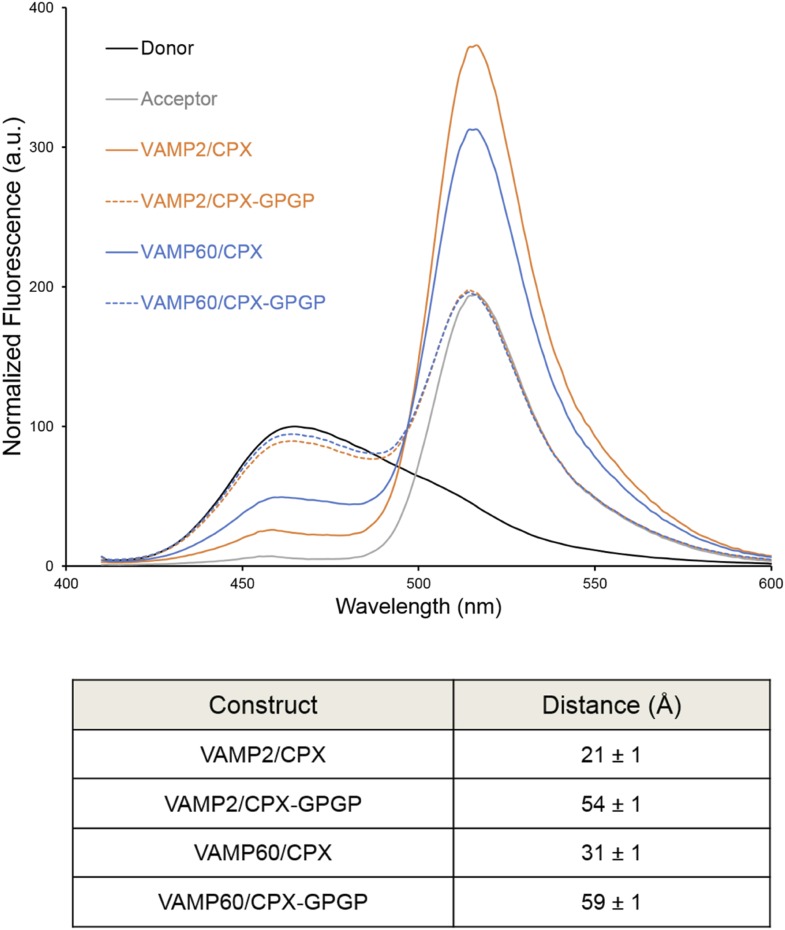
Bimane–Oregon green fluorescence resonance energy transfer (FRET) experiments probing the effect of flexibility on complexin (CPX) orientation in pre- and post-fusion CPX–SNARE complexes.The FRET labeling positions were residue 193 on SNAP25 (Bimane) and residue 38 on CPX (Oregon green). Fluorescence emission spectra of Bimane only (black), Oregon green only (grey), and Bimane–Oregon green labeled CPX–SNARE complexes containing VAMP2 (residues 25–96, orange), VAMP60 (residues 25–60, blue) confirms the angled (low FRET) configuration of CPX accessory helix (CPXacc) in the pre-fusion SNARE complex (VAMP60). The near complete loss of FRET for the flexible CPX mutant (helix breaking GPGP insertion between CPXacc and CPC central helix (CPXcen); CPX–GPGP, dashed lines) compared with the wild-type (WT, solid lines) in both pre- and post-fusion SNARE complexes shows that the difference in FRET signal observed with WT CPX is not due to increased flexibility of the CPXacc in the pre-fusion complex. FRET distances in these CPX–SNARE complexes determined from the quenching of the donor (Bimane) fluorescence is shown (table) and standard deviations are reported from 2–3 independent experiments.